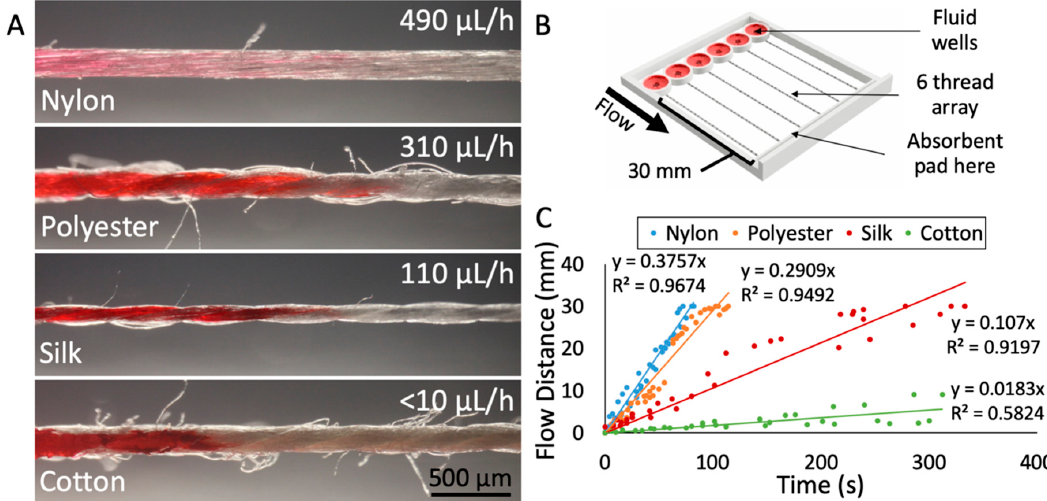
Figure 2. Characterization of different thread materials. ( A ) Photographs of the four threads tested (nylon, polyester, silk, and cotton), with average fluid flow rate indicated. The corresponding flow velocities for each thread are 381 μ m/h (nylon), 275 μ m/h (polyester), 104 μ m/h (silk), and <10 μ m/h (cotton). The images were captured at the wicking front with red dye loaded from the left. ( B ) 3D rendering of the test apparatus used to measure flow velocities. ( C ) Results from flow velocity testing of the four thread types. Individual measurements indicated as dots. Five trials were performed per thread type, with six measurements taken per trial.